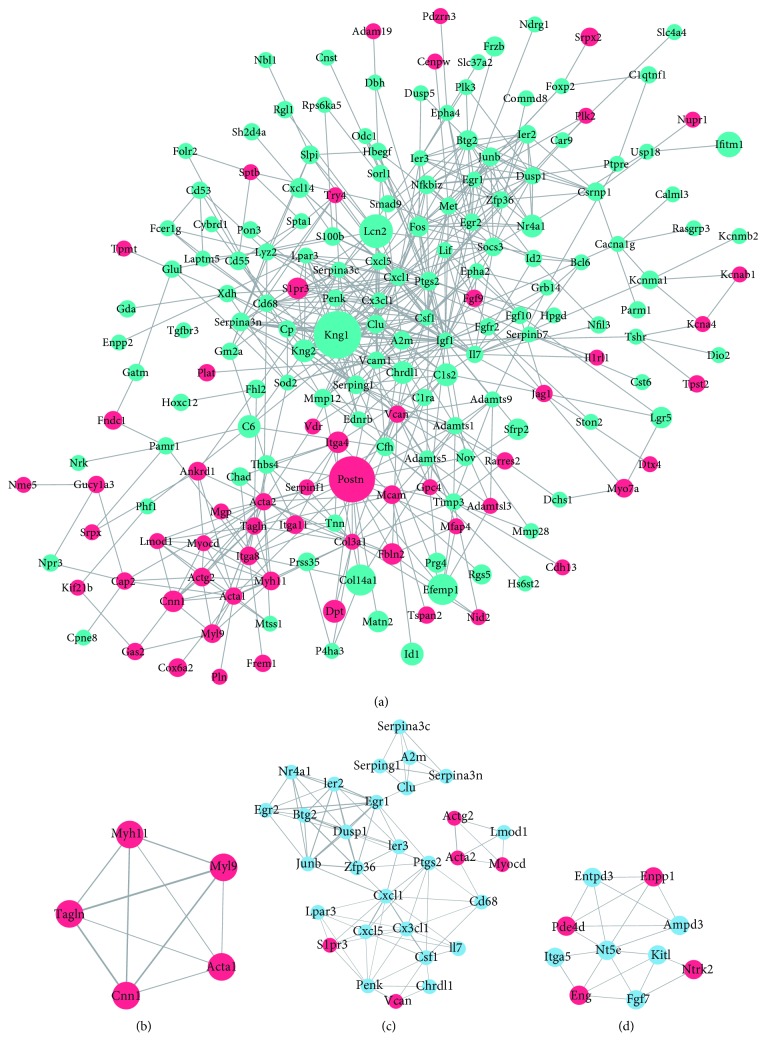
Protein-protein interaction network and significant modules of differentially expressed genes. (a) Red: significantly downregulated genes; green and light blue: significantly upregulated genes. Node size is positively related to fold change; edge width is positively related to the combined score. (b, c, d) Significant modules in the protein-protein interaction (PPI) network with a MCODE score ≥ 4: (b) module 1 (score = 5); (c) module 2 (score = 6.276); and (d) module 3 (score = 4.444).